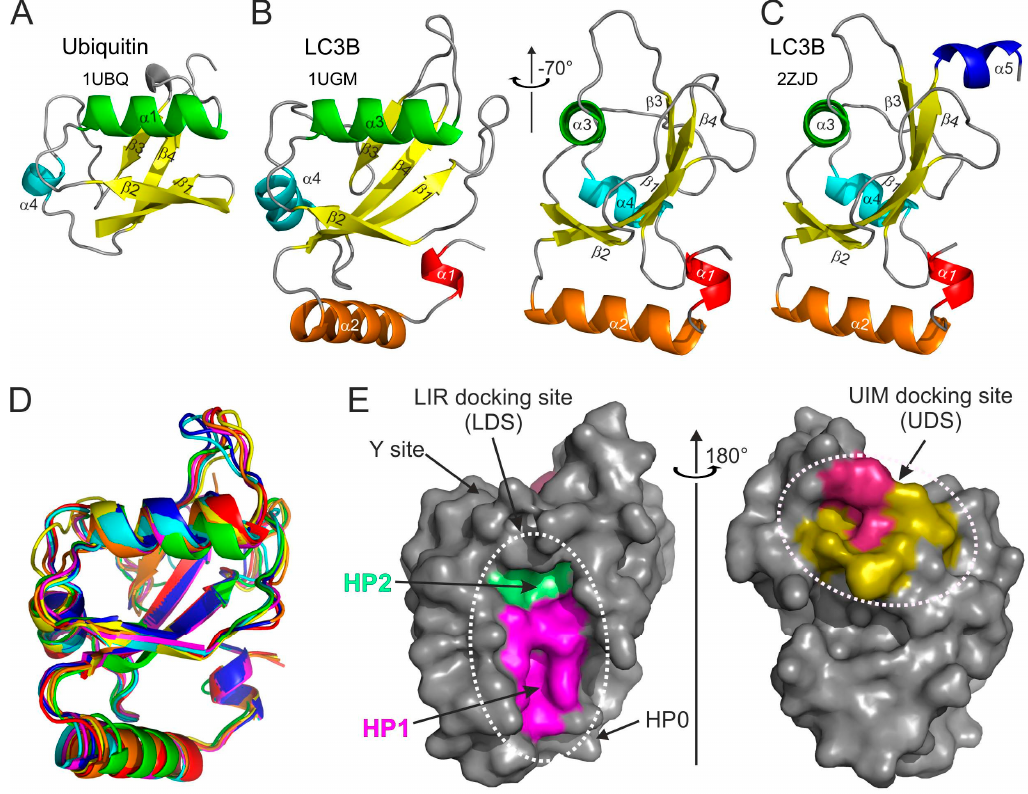
Figure 1. Structural features of ubiquitin and Atg8/LC3/GABARAP proteins. Ribbon diagrams of the ( A ) ubiquitin and ( B ) LC3B structures aligned to the common ubiquitin core (left plot in B ). The right plot was generated by rotation of the LC3B structure by − 70° around the Y -axis. The secondary structure elements in both proteins are colored in rainbow color-code from α -helix α 1 in LC3B (red-orange-green-cyan-blue), all β -strands are colored yellow. The PDB ID codes of each structure are presented under the protein names. ( C ) LC3B structure with C -terminal α -helix α 5 (the same orientation as the right plot in (B)). ( D ) Structural alignment of yeast Atg8 and human LC3A, LC3B, LC3C, GABARAP, GABARAPL1, and GABARAPL2 (rainbow color-code) proteins shown as ribbon diagrams (the same orientation as the left plot in ( B )). ( E ) Left plot: surface representation of LC3B structure (the same orientation as the left plot in ( B )), showing the main interacting sites—HP1 (magenta) and HP2 (light green), which form the LC3 docking site (LDS). Position of additional interacting sites, like HP0 [50] , Y-site [51] ,